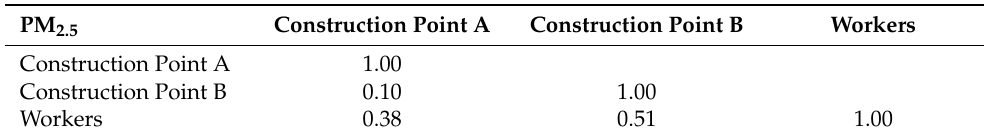
Table 4. Correlation coefficient (r) between PM 2.5 and workers in Point A and B of the construction area. PM 2.5 Construction Point A Construction Point B Workers Construction Point A 1.00 Construction Point B 0.10 1.00 Workers 0.38 0.51 1.00